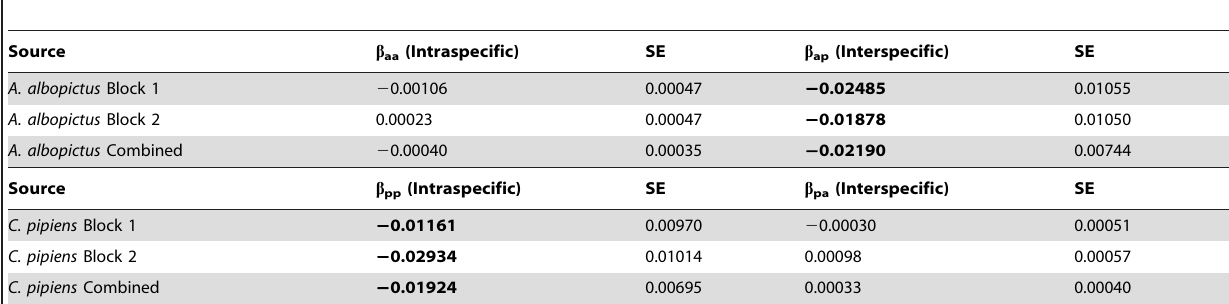
Table 6. Estimates of intra- and interspecific competitive effects for the pairwise response surface experiment Aedes albopictus vs. Culex pipiens .